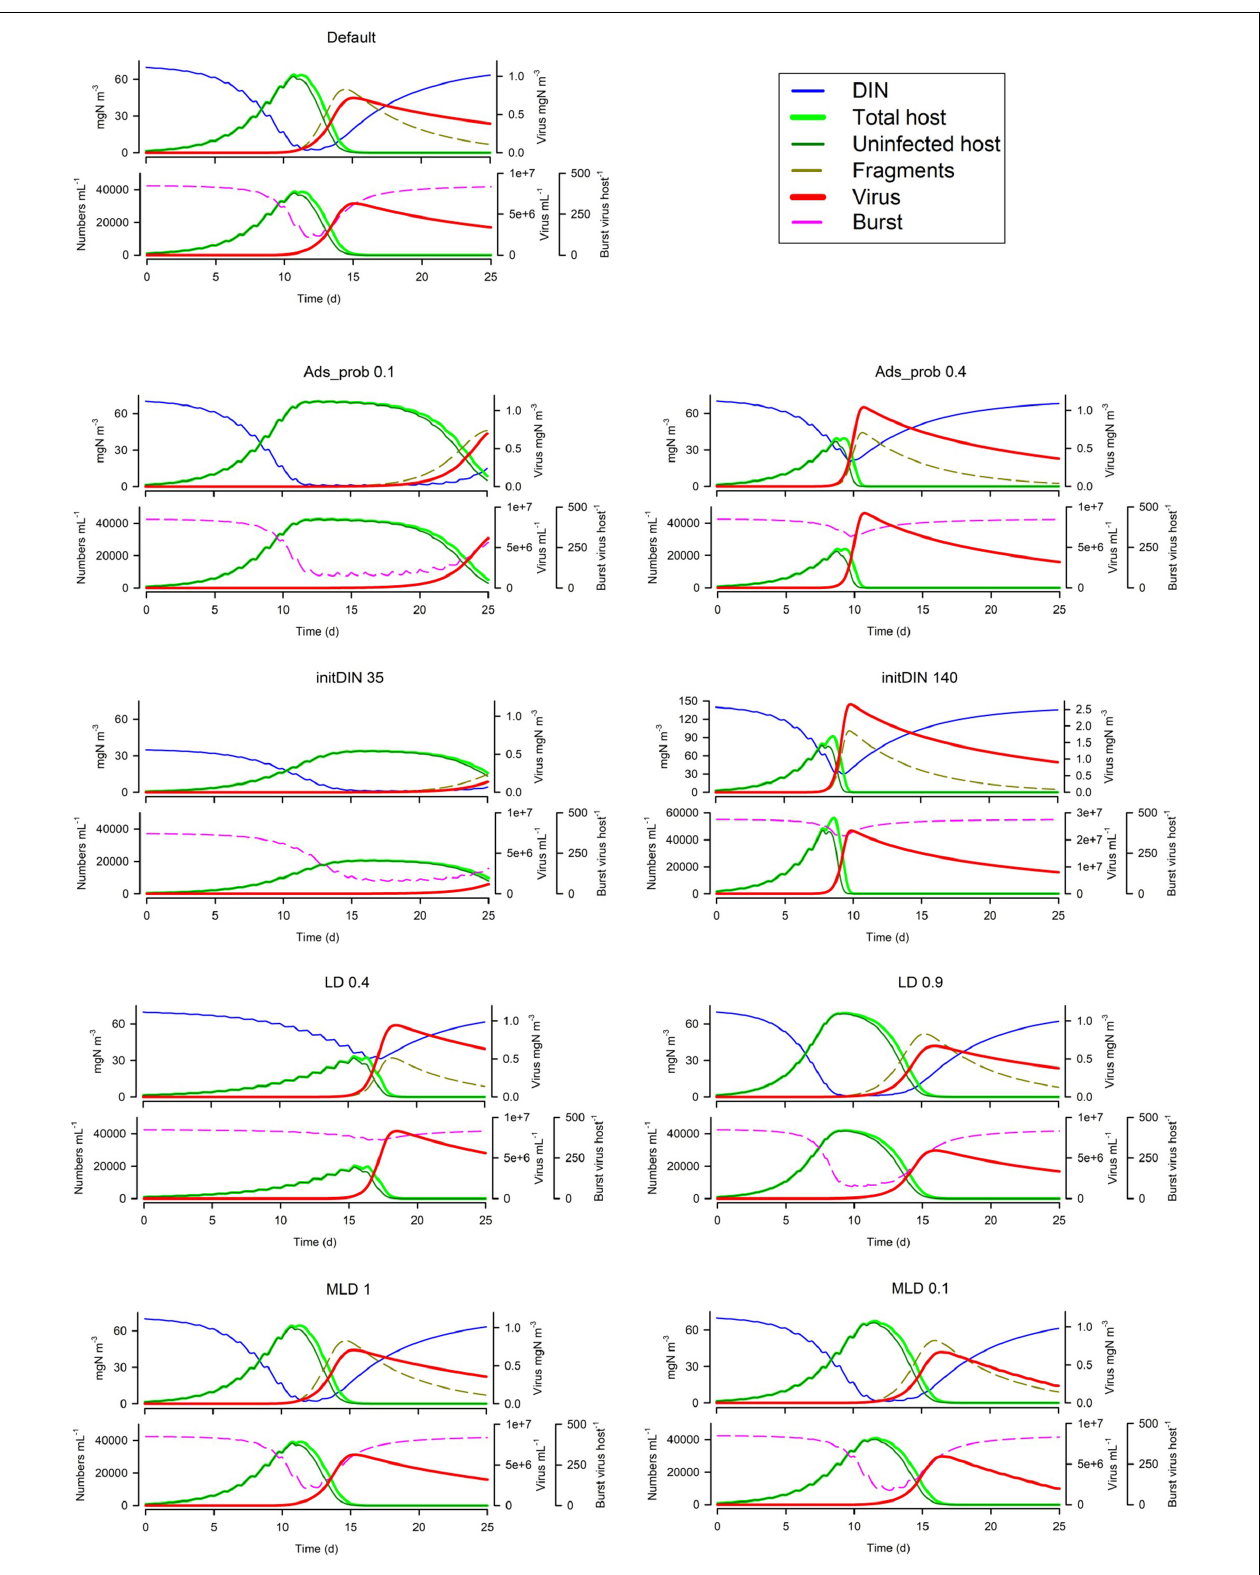
FIGURE 4 | Effects of changing the global absorbance value ( Ads_prob ), the amount of nutrient in the system ( initDIN ), the light:dark periodicity ( LD ), and the mixed layer depth ( MLD ). The Default ( Figure 1B ) is reproduced in the top left-hand corner. See also Table 5 .